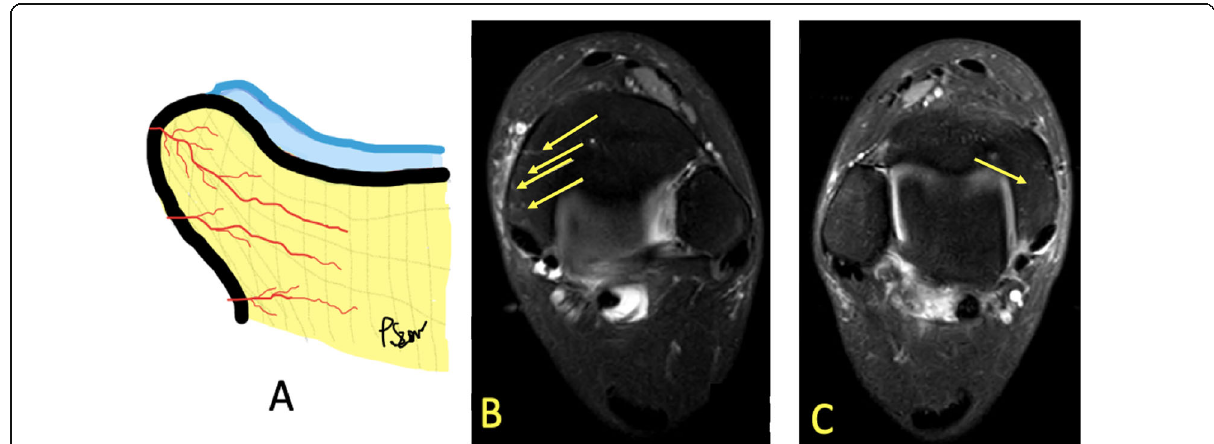
Fig. 25 A 32-year-old runner with 1-month history of right medial ankle pain and suspected stress fracture of the medial malleolus. a Drawing of blood vessels in the bone marrow. b MRI showed hyperemia of bone marrow in the medial malleolus on the symptomatic side (arrows). c On the contralateral side, no vessels were visualized